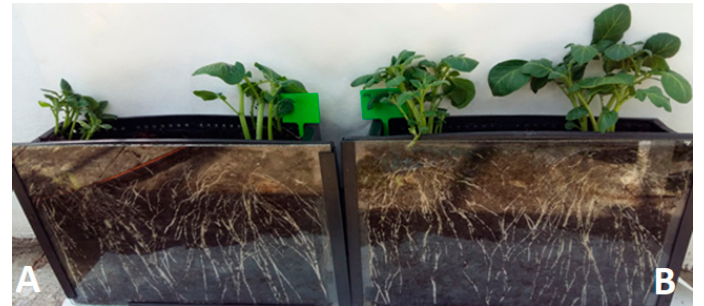
Figure 5. Plants obtained from seed potatoes: ( A ) infected with phytopathogens; ( B ) biologically treated and then infected with phytopathogens.